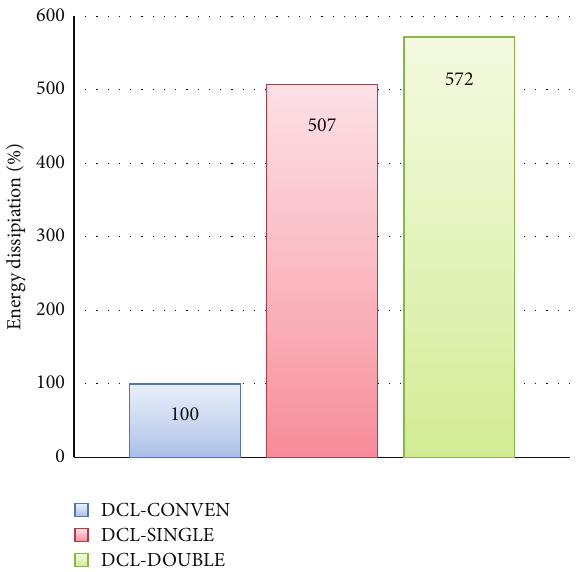
Figure 16: An energy dissipation capacity comparison for the DCL group.